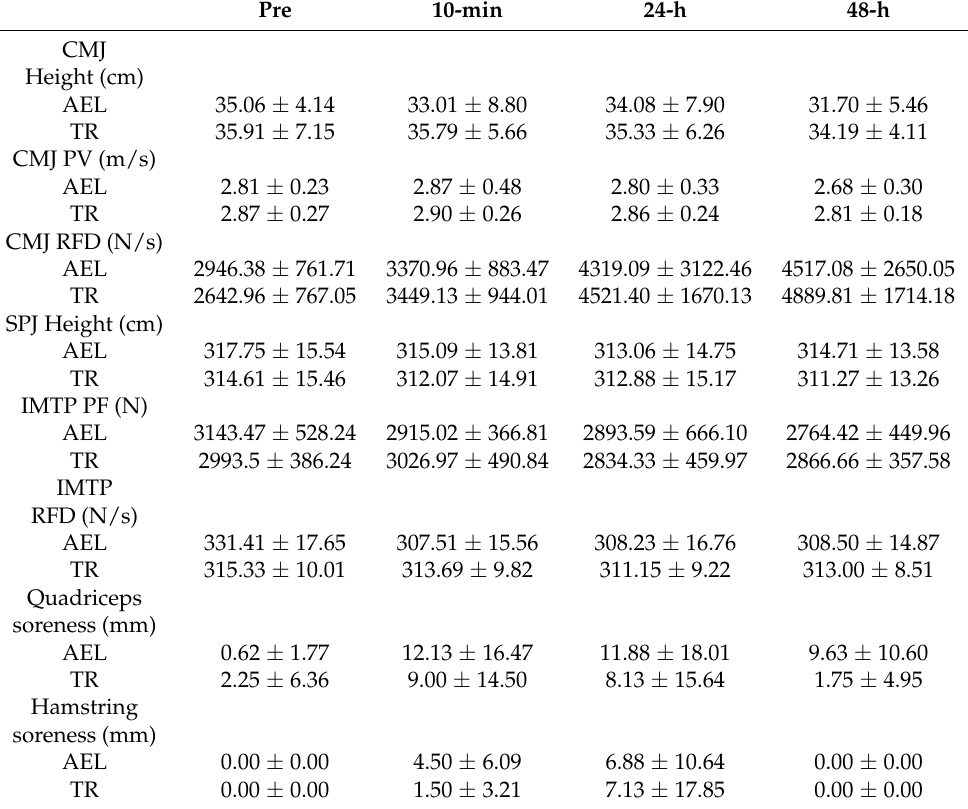
Table 1. Mean ± SD for CMJ height, peak velocity, RFD, SPJ height, IMTP peak force and RFD, and muscle soreness before (Pre), 10 min (10-min), 24 h (24-h), and 48 h (48-h) after a single bout of half-squat exercise for AEL and TR